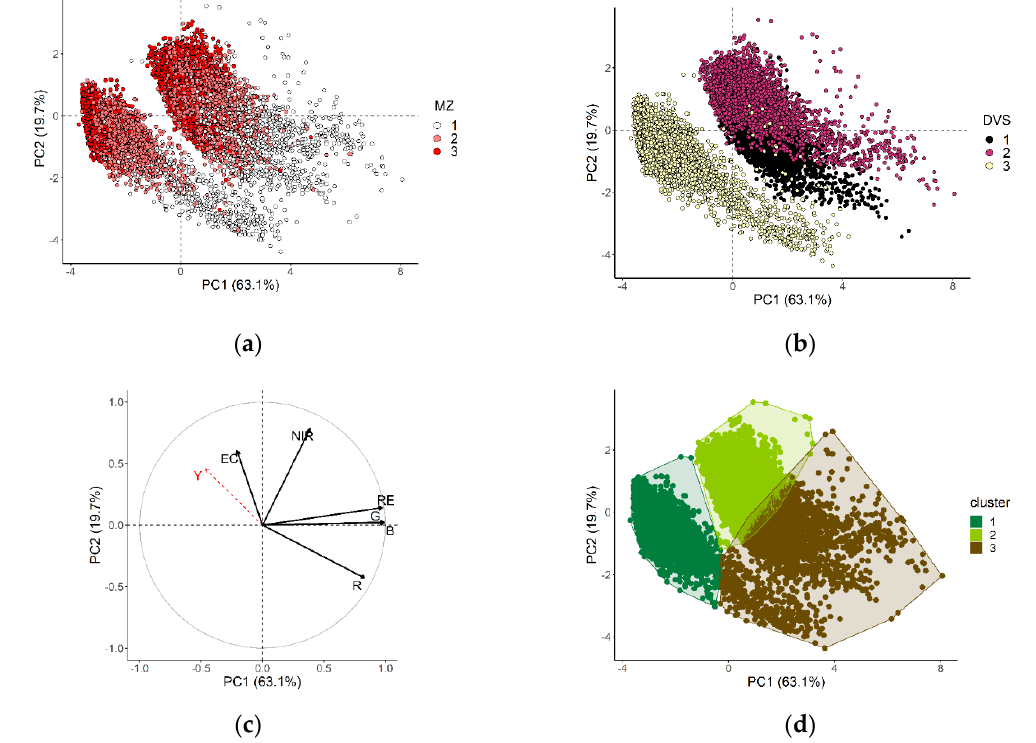
Figure 3. Results of principal component analysis (PCA). PCA score plots of individuals (pixels) showing the pixels in the first two principal components space marked according to ( a ) the yield-based management zones, and ( b ) the development stages at the time of crop monitoring (DVS: 1, 2, and 3 corresponded to eTl, StEl, and lB). ( c ) PCA plot of the original variables projected into the first two principal components space. ( d ) PC score-plot showing the three extracted clusters.